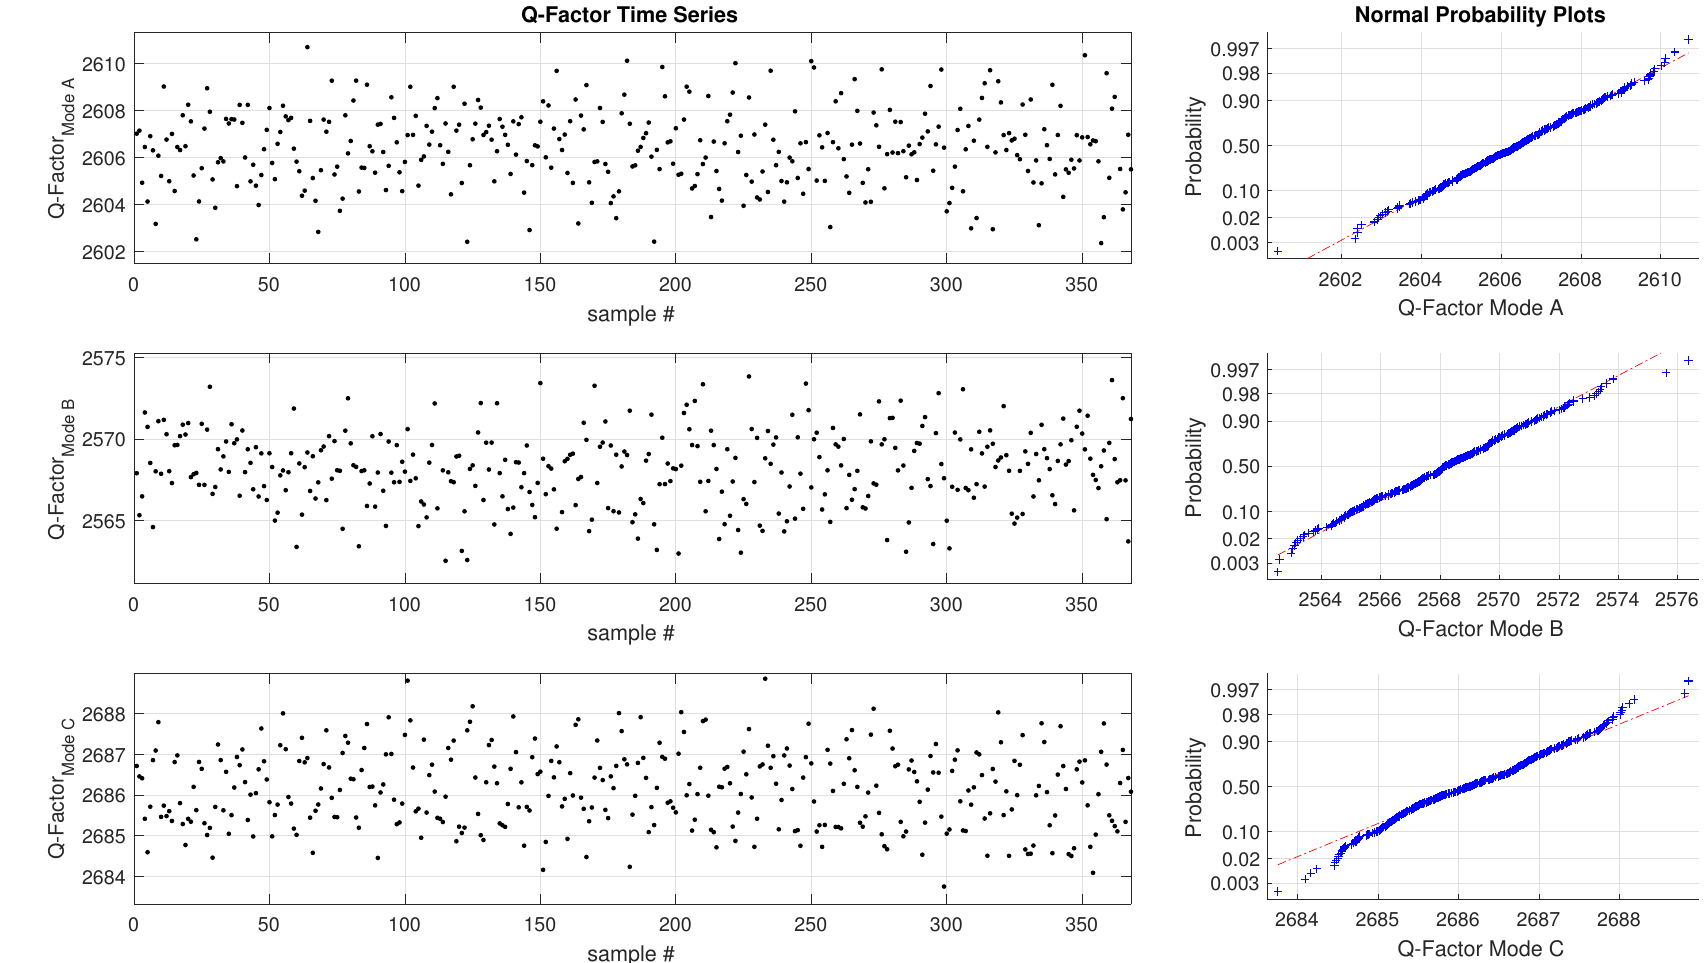
Figure 7. Q-factor data, simultaneous measurement of three modes, U-tube filled with